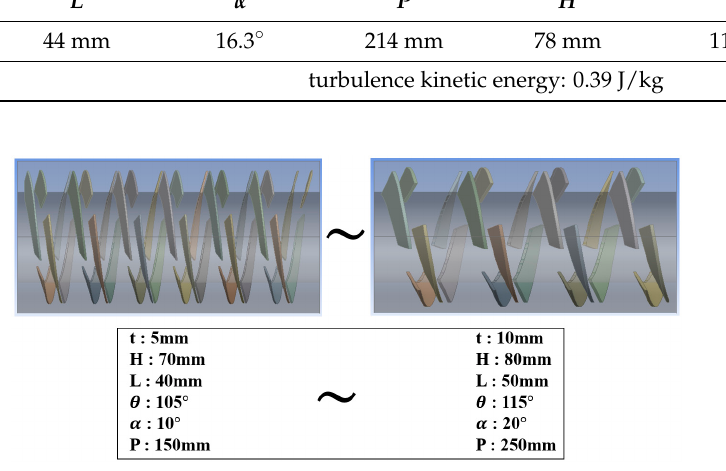
Figure 19. Resetting for ranges of design parameters relating to blade gap.